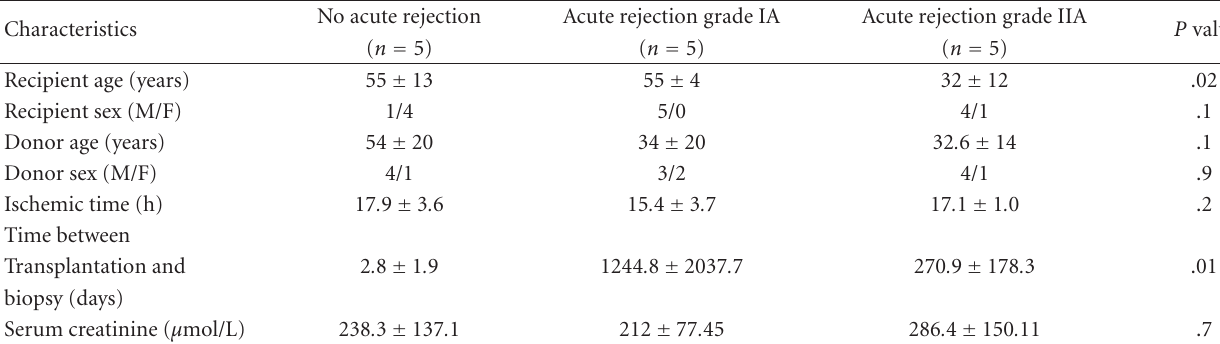
Table 1: Patients